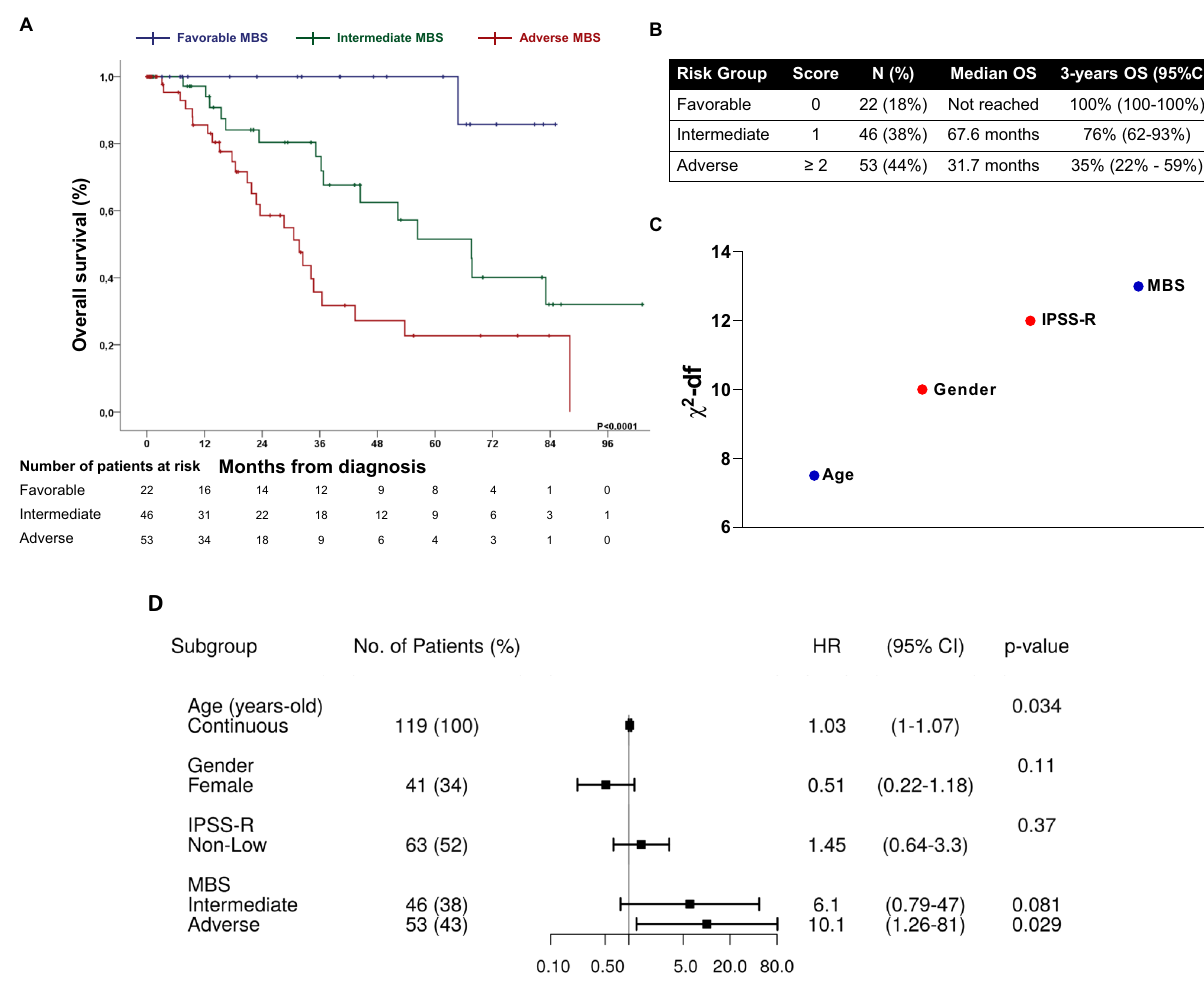
Figure 2. Survival analyses of Molecular-Based Score (MBS) on overall survival (OS) of myelodysplastic syndrome. ( A ) Kaplan–Meier curves for the three MBS risk categories. ( B ) MBS was built based on gene expression of ACLY , ANPEP , PANK1 , PKM and SLC25A5. MBS efficiently identify three risk groups. ( C ) Significance ( χ 2 -statistic) of each covariate for prediction of OS in the multivariate model, in which higher values represents increased predictive capacity; df: degrees of freedom. ( D ) Forest plot for multivariable analysis identified adverse risk-MBS and age as independent predictors of OS. Hazard ratios (HR) > 1 indicates that increasing values for continuous variable or the first factor for categorical variables has the poorer outcome. HR and their respective 95% confidence interval (95%CI) are indicated with black square and a line, respectively. IPSS-R non-low patients included intermediate, high and very-high